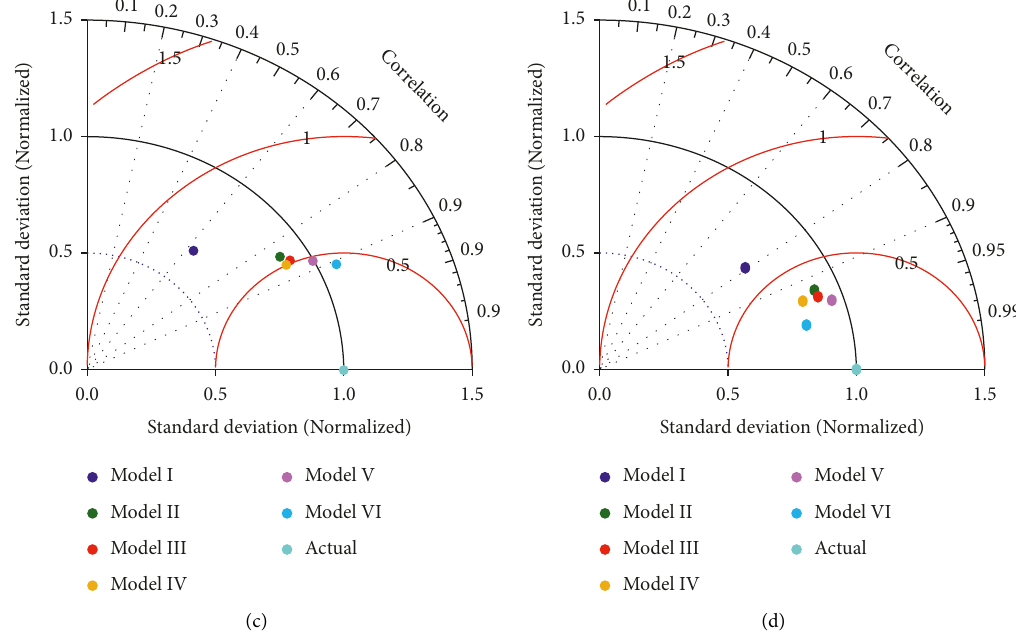
Figure 14: Taylor diagram for the developed AI models using all input combinations. (a) DLNN model. (b) MARS-model. (c) ELM-model. (d) RF-model.